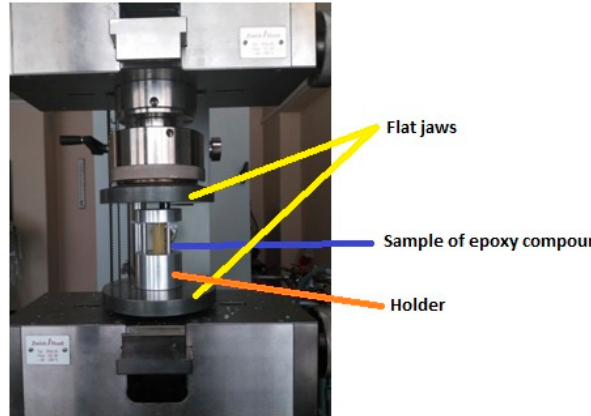
Figure 4. View of the mounted epoxy compound sample.